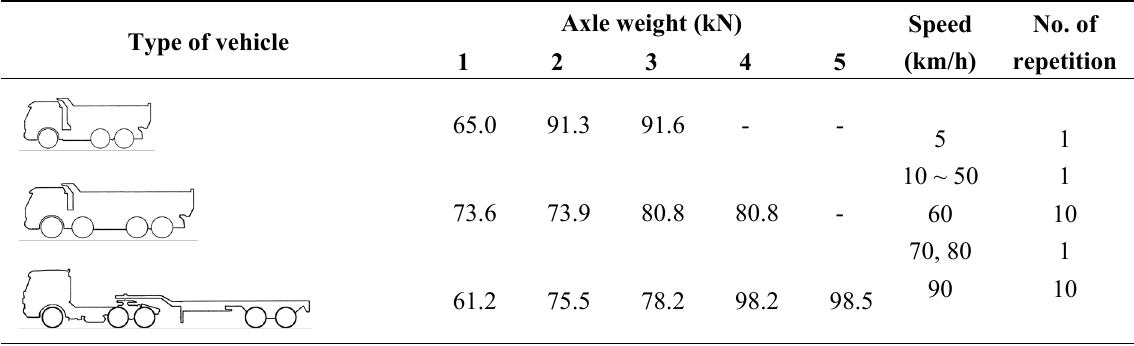
Table 1. Weight of test trucks and test cases of Geumdang